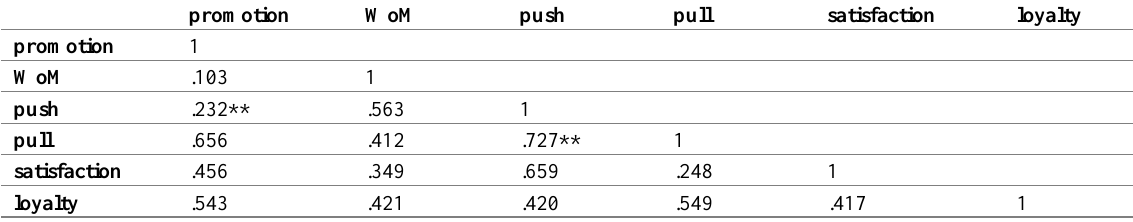
Table 4: Correlation between variables